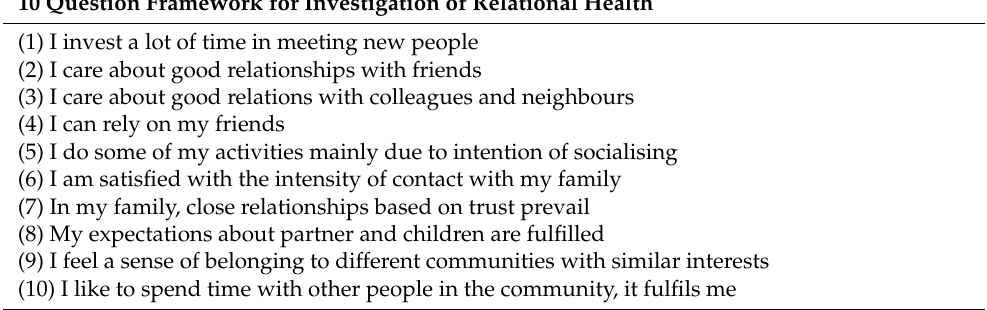
Table A1. 10-question framework for investigation of relational health.